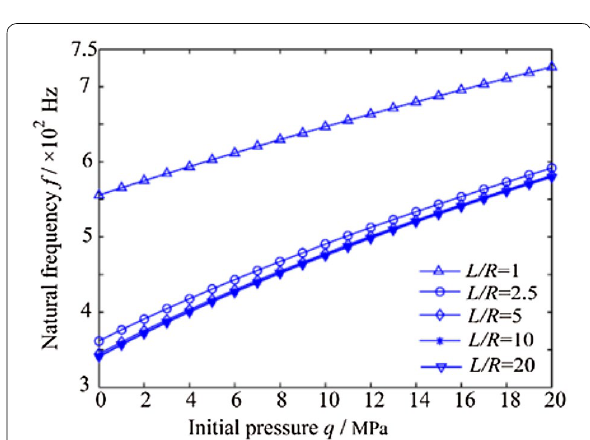
Figure 5 Variation of the natural frequency against q for several special values of L /